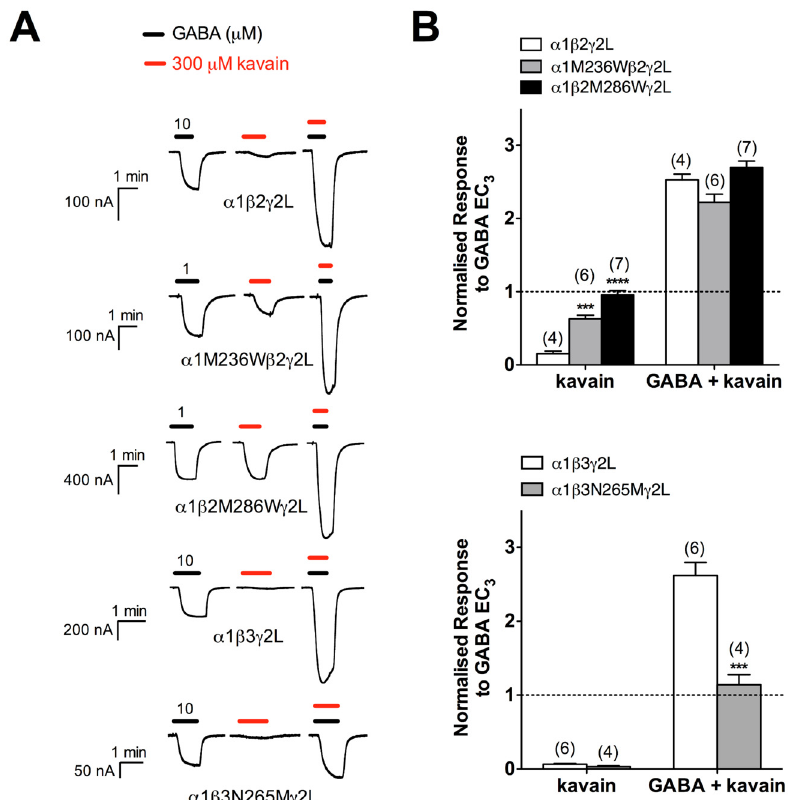
Fig 7. The pronounced effect of β 3N265M point mutation on etomidate and propofol sensitivity. (A) Representative traces demonstrating the modulatory effect of 3 μ M etomidate and 10 μ M propofol on GABA EC 3 ( left ) and the agonist effect of 30 μ M etomidate and 100 μ M propofol relative to 10 mM GABA ( right ) at α 1 β 3 γ 2L and α 1 β 3N265M γ 2L GABA A Rs. (B) The modulatory and agonist effects of etomidate and propofol were markedly diminished at α 1 β 3N265M γ 2L GABA A Rs. Data are normalised to current responses elicited by 10 mM GABA, and are presented as mean ± SEM. *** p < 0.001; **** p < 0.0001; unpaired t test (mutant vs . wild-type). Numbers above bars indicate number of experiments. GABA + ETO: GABA EC 3 + 3 μ M etomidate; ETO: 30 μ M etomidate; GABA + PRO: GABA EC 3 + 10 μ M propofol; PRO: 100 μ M